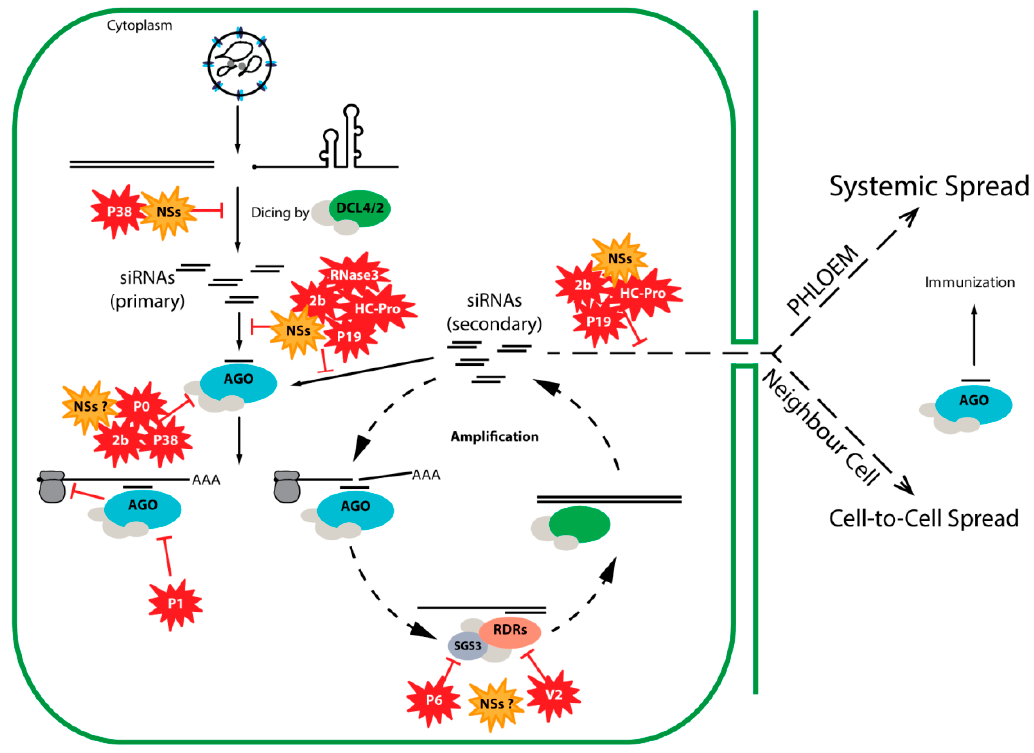
Figure 3. Schematic representation of plant antiviral RNA silencing and the counter-strategies used by several viral RSS proteins (indicated by the red symbols and, in the case of tospovirus NSs, orange symbols). AGO: argonaute protein; DCL: dicer-like protein; RDR: host-encoded RNA-dependent RNA polymerase; SGS3: protein suppressor of gene silencing 3; HC-Pro: helper component-proteinase; siRNAs: small interfering RNAs.